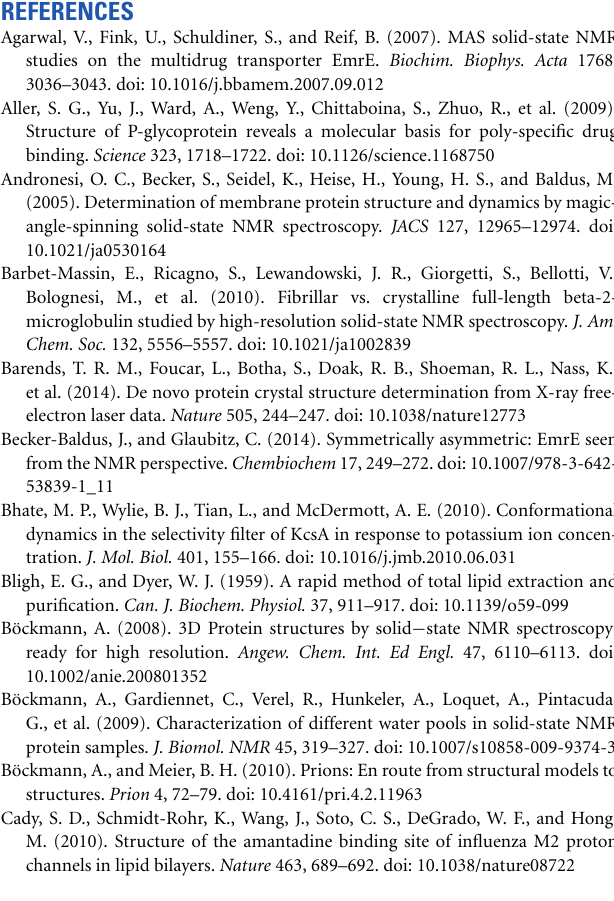
α -helices, β -sheets, and coils. The overall distribution, for the example of alanine chemical shifts, is shown in Figure 5B